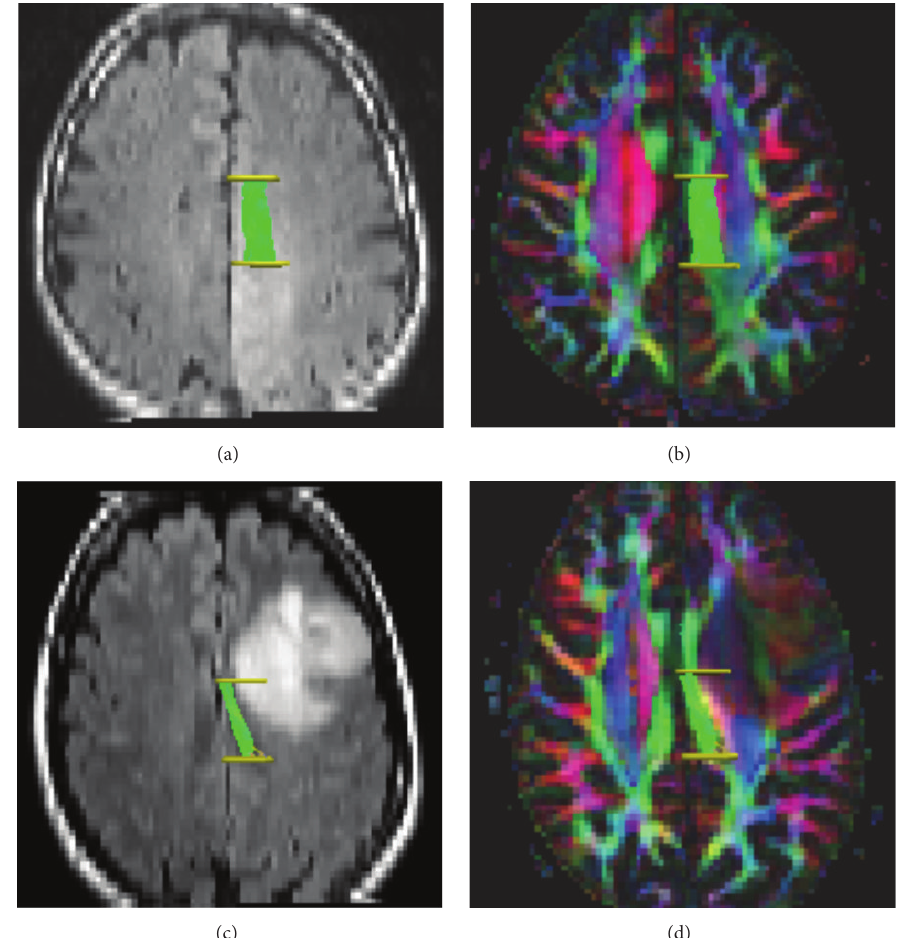
Figure 3: Tractography of segment 2 of the cingulum in two different patients (patient number 14 and patient number 25). ((a)-(b)) Patient with an astrocytoma grade III. (a) 3D-tractography of segment 2 of the cingulum overlaid on T2-FLAIR image shows tumor infiltrating the area of the tract segment. ROIs number two and three in yellow. (b) 3D-tractography in the same patient, segment two of the cingulum overlaid on 2D FA-color map. ((c)-(d)) Patient with an oligodendroglioma grade II. (c) 3D-tractography of segment 2 of the cingulum overlaid on T2-FLAIR image shows tumor dislocation of the tract segment. ROIs number two and three in yellow. (d) 3D-tractography in the same patient, segment two of the cingulum overlaid on 2D FA-color